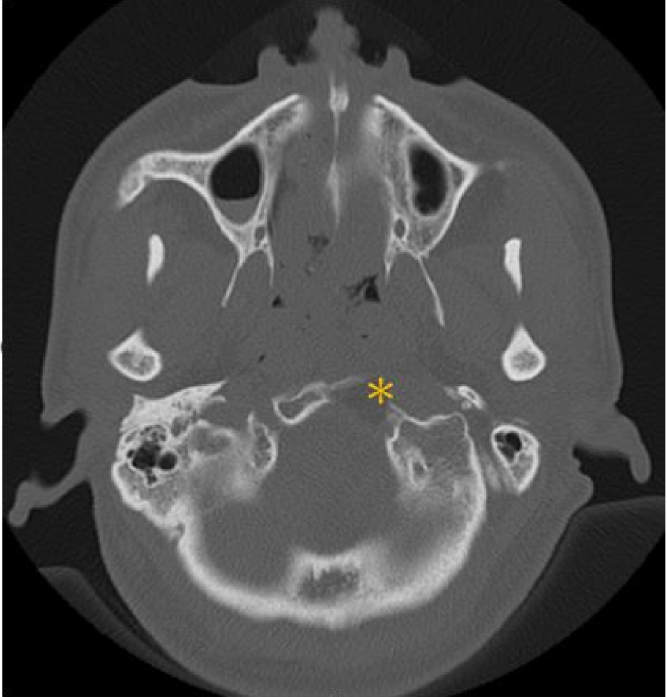
Figure 4. Post-operative CT scan disclosed a well-decompressed hypoglossal canal